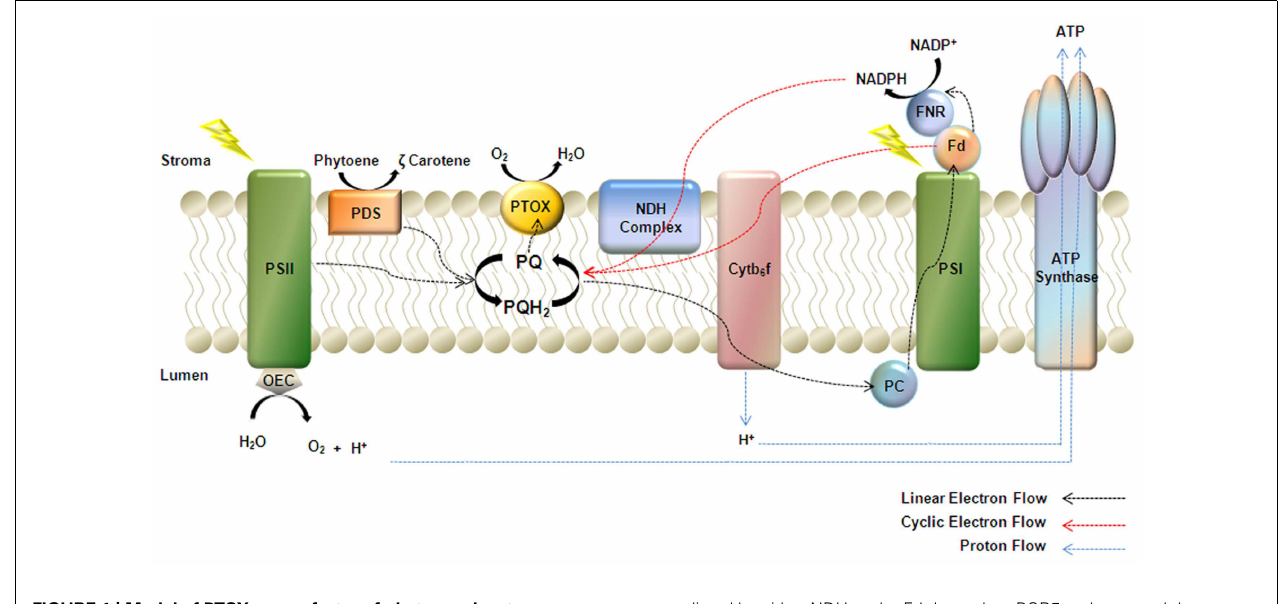
FIGURE 1 | Model of PTOX as a cofactor of phytoene desaturase (PDS). PTOX is a plastoquinol terminal oxidase that regulates the redox state of the plastoquinone pool (PQ) during early chloroplast biogenesis. Electrons from linear electron flow, cyclic electron flow